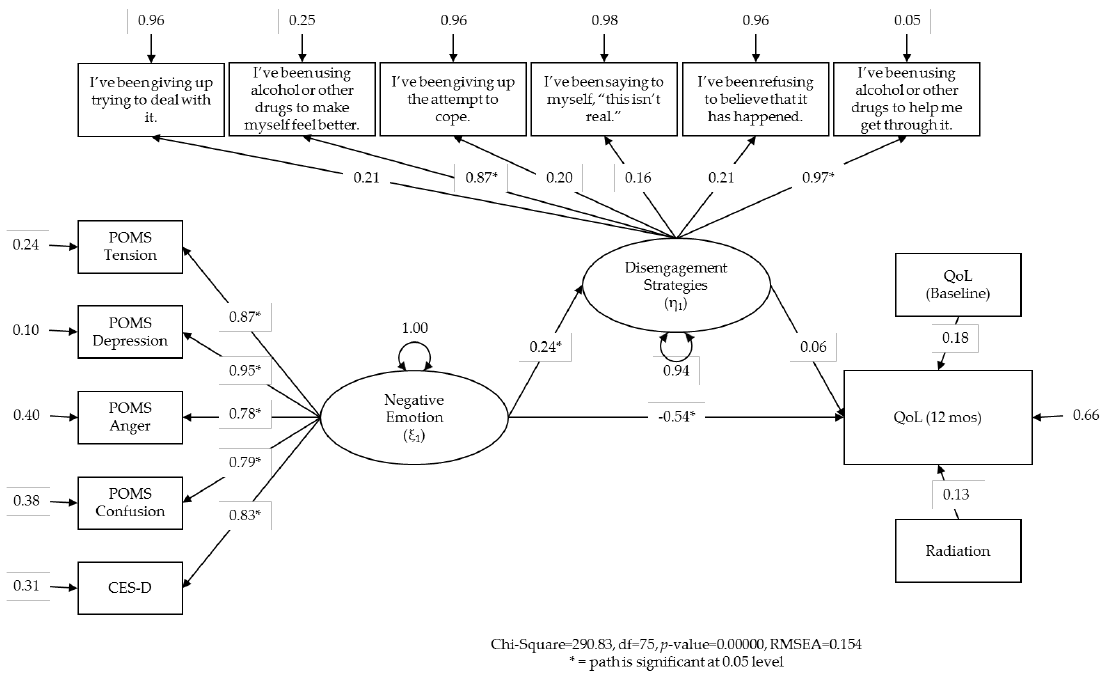
Figure 4. Final structural equation model testing variable relations that are consistent with the mediating effect of disengagement on the relationship between emotion and quality of life. Disengagement is represented as a latent variable.